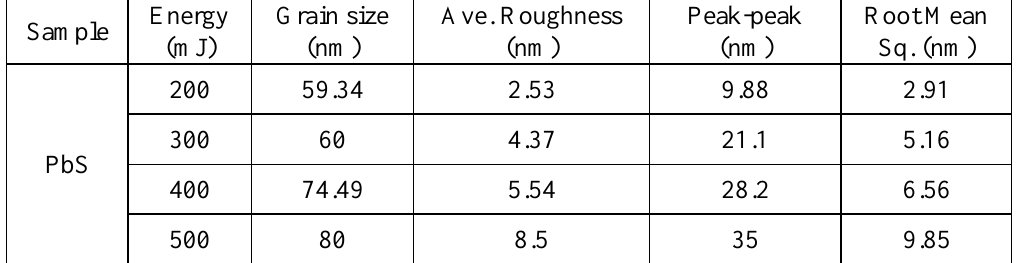
Table 2: The AFM analyze parameters of PbS nanostructure with different laser energies at a constant thickness (t~200 nm).